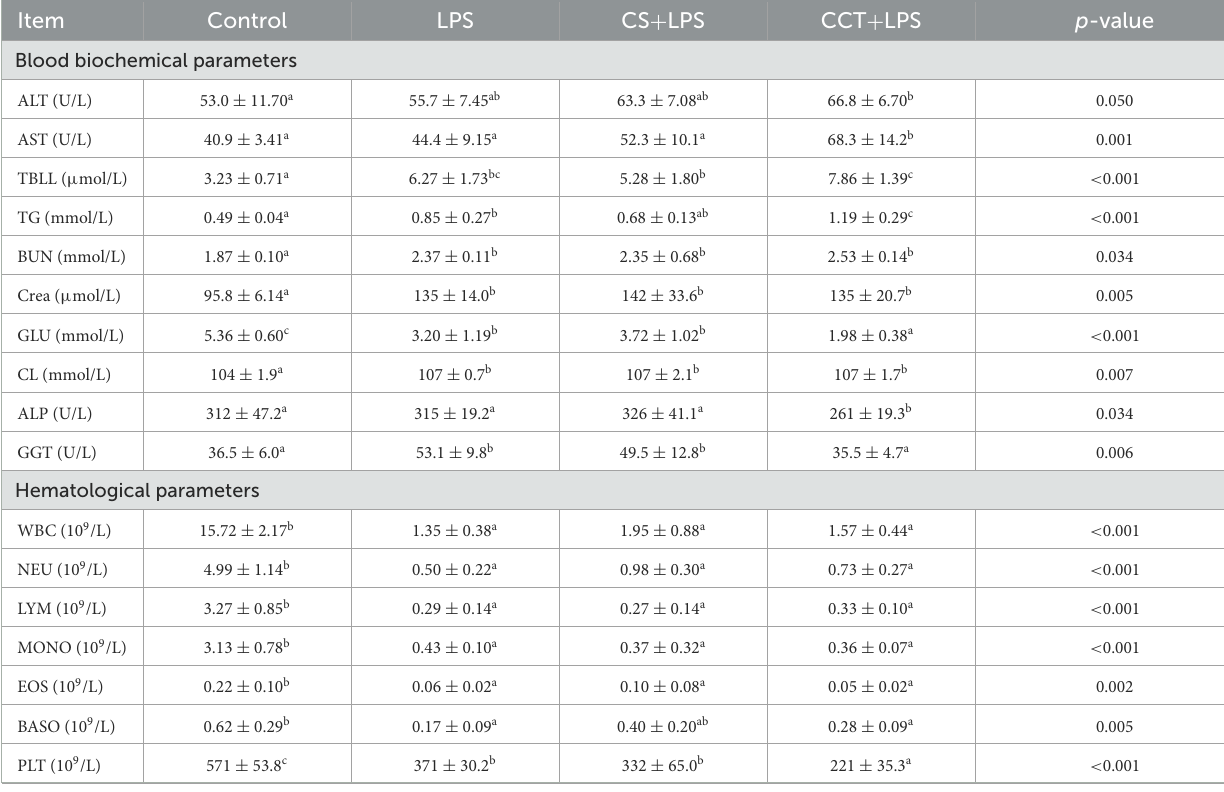
TABLE 4 Effects of CCT supplementation on blood biochemical parameters and hematological parameters in weaned piglets after LPS challenge. Item Control Blood biochemical parameters